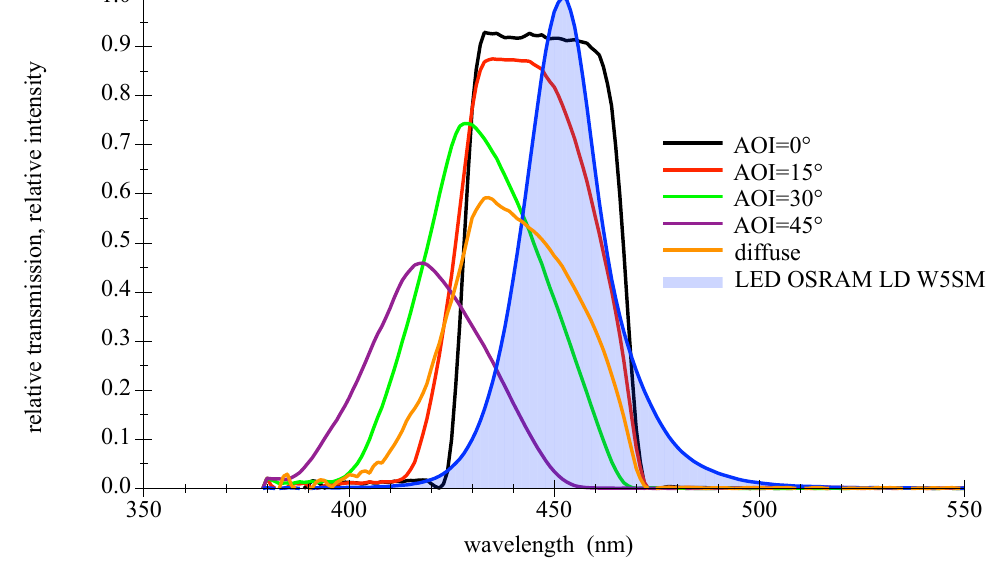
Figure 11. Measured spectral transmission curves for a thin film bandpass filter Thorlabs FB450-40 with a directed light source at different AOIs and with a diffuse light source. The measured relative intensity distribution of a deep blue LED OSRAM LD W5SM is also given as filled curve to illustrate the overlap. For further information please refer to the appendix in Appendix